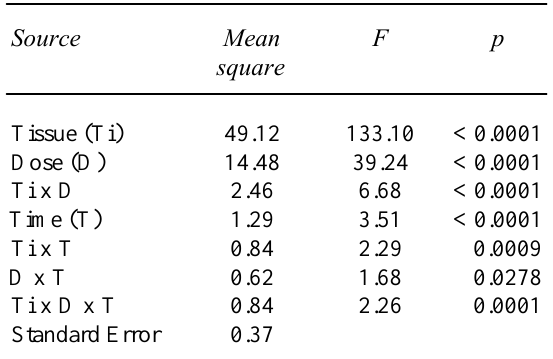
Table 1: Statistical analysis of bioconcentration /